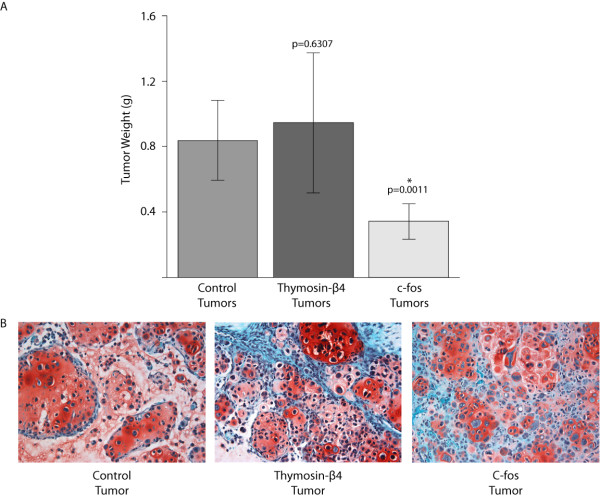
Tumor weight following induction of subcutaneous tumors with SRC cells overexpressing either thymosin-β4 or c-fos. Control tumors were initiated with SRC cells that express the MSCV viral vector with no insert (pMSCV-I-Hygro vector). C-fos tumors were initiated with SRC cells that overexpress c-fos (MSCV-cfos-I-Puro). Thymosin-β4 tumors were initiated with SRC cells that overexpress thymosin-β4 (MSCV-Thyβ4-I-Puro). Overexpression of c-fos resulted in the formation of tumors that were significantly smaller than control tumors. The bar represents the average invasion indices of biologic replicates, and the error bars represent the standard deviation of the biologic replicates. '*' Indicates that the tumor weight is significantly different than the tumor weight of the control tumors (p-value <0.05 considered significant). n = 10 for control tumors and c-fos tumors. n = 9 for thymosin-β4 tumors (one animal died prematurely and was found to have multiple chondrosarcoma lung metastases). See Additional file 4 for complete list of tumor weights. (B) Photomicroscopy of histological sections obtained from SRC tumors (20 × magnification). Tumors induced from control cells (SRC cells expressing the empty viral vector), and from SRC cells overexpressing either Thymosin-β4 (Thymosin-β4 tumor) or c-fos (C-fos tumor). Approximately 30 days following tumor induction animals were sacrificed and tumors were removed for histology. Sections representative of each tumor are shown. All tumors were classified as histologic grade II chondrosarcomas. The SRC cells are stained with Safranin O (red).